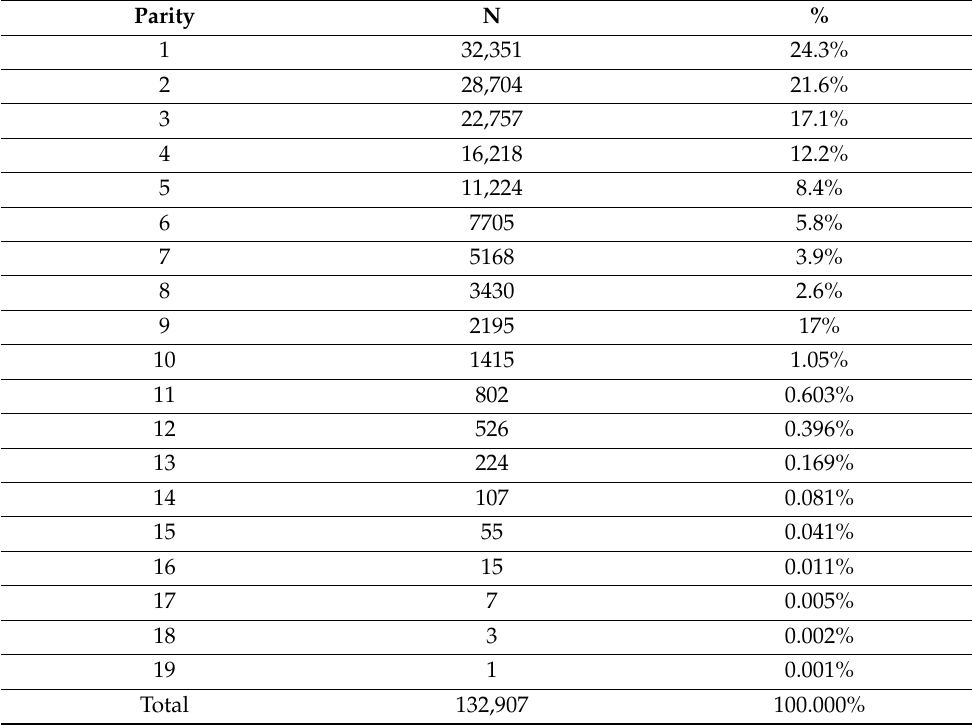
Table A1. Distribution of deliveries by maternal